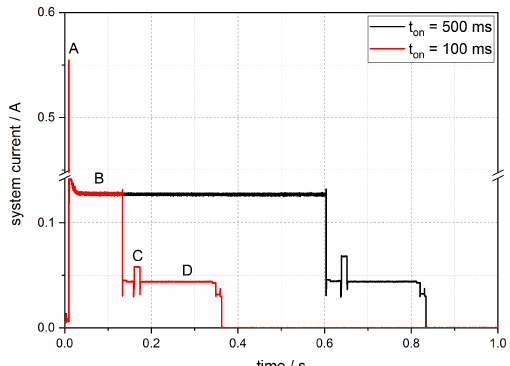
Figure 4. Comparison of different t on times of the gas sensor. Due to the fast heating of the MEMS-based hotplate, the t on time could be decreased to 100ms. This increases the battery lifetime signifi- cantly. The runtime of one measurement cycle can be divided into four stages. (A: system start up; B: sensor heating time; C: data pro- cessing; D: communication with the